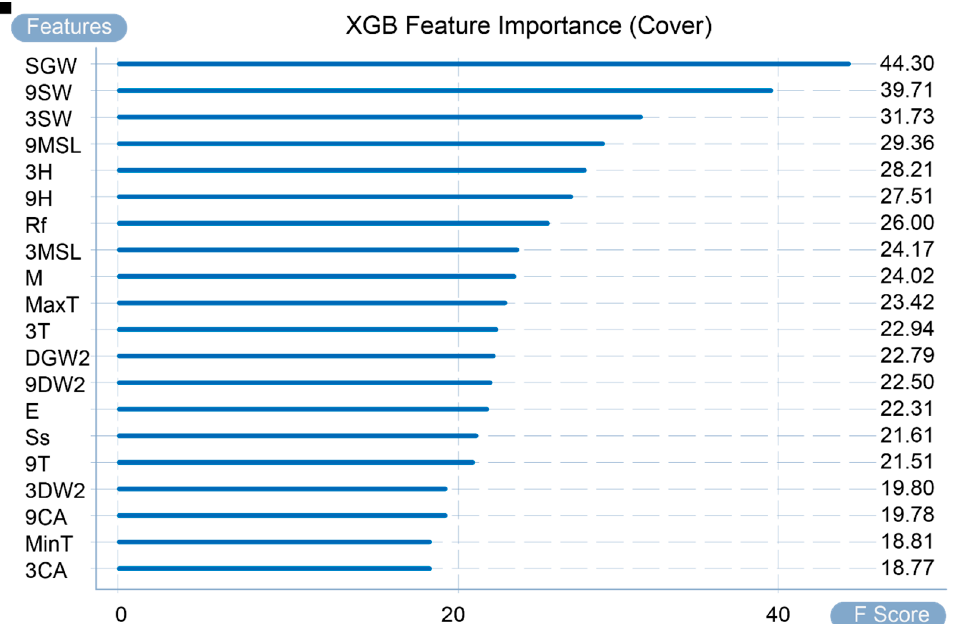
Figure 7. Feature importance by coverage.